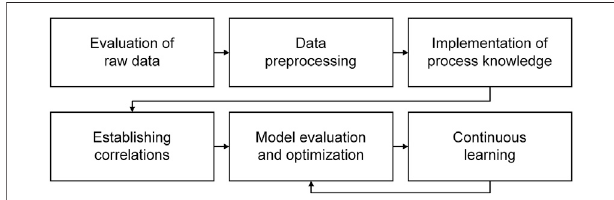
FIGURE 1 | Basic work fl ow of soft sensor development. A loop exists between model evaluation and optimization and continuous learning; however, revisions of the fi rst four steps will in many cases be necessary to develop a suf fi ciently accurate and robust soft sensor.